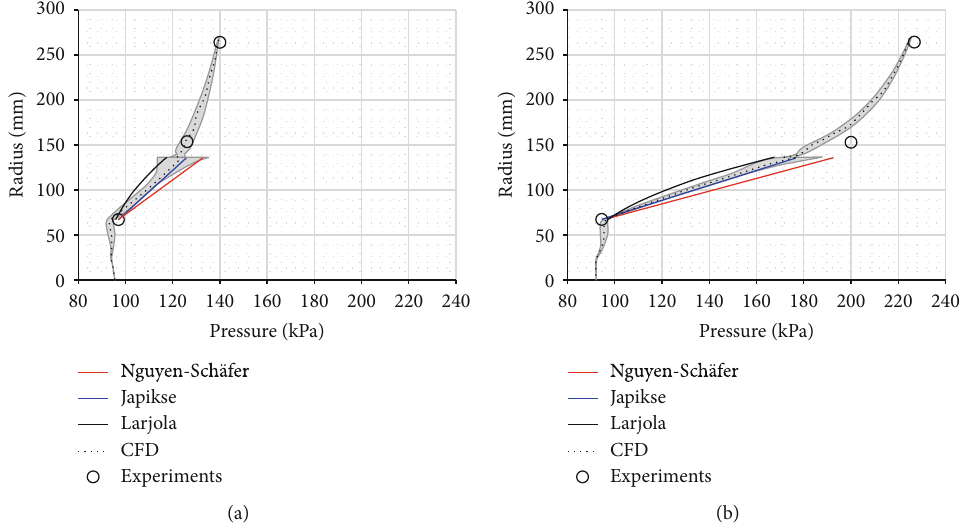
Figure 10: Pressure distribution on the shroud. Solid lines: three methods, dotted line: CFD, gray area: discretization error, and circles: experiments. (a) Point 1. (b) Point 9. Points 2 – 8 fall within these two